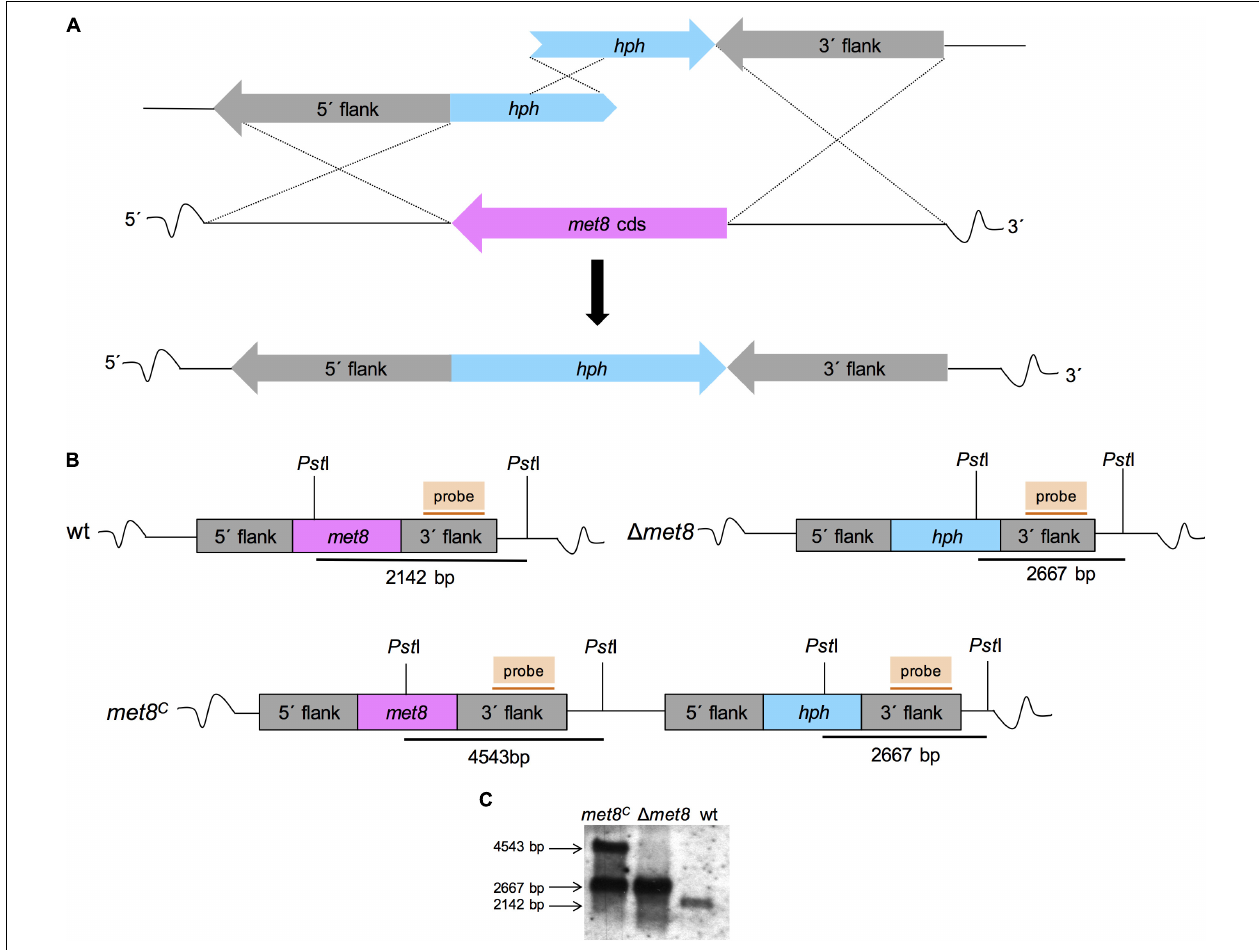
FIGURE 2 | Deletion and reconstitution of the met8 gene in A. fumigatus . (A) Schematic view of the split-marker technique-mediated deletion of met8 in A. fumigatus wt AfS77. (B) Genomic organization of the met8 locus in wt, (cid:49) met8 and met8 C . Genomic DNA digestion with PstI resulted in a 2.1-kb for the wt, a 2.6-kb for (cid:49) met8 and a 2.6-kb and 4.5-kb fragment for met8 C , respectively. (C) Southern blot analysis of genomic DNA of wt, (cid:49) met8 and met8 C using hybridization probes indicated in (B) confirming the genetic manipulation.